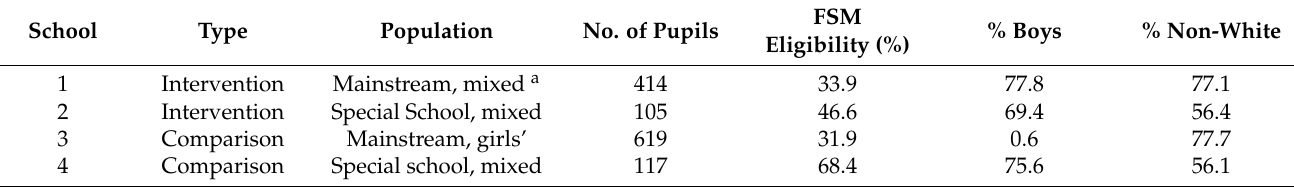
Table 1. Characteristics of Intervention and Comparator Schools .